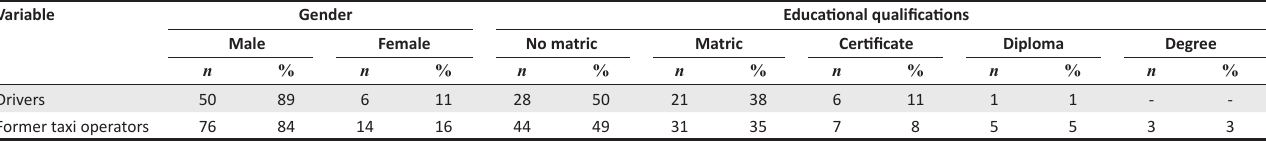
TABLE 2: Demographics details of respondents. Variable